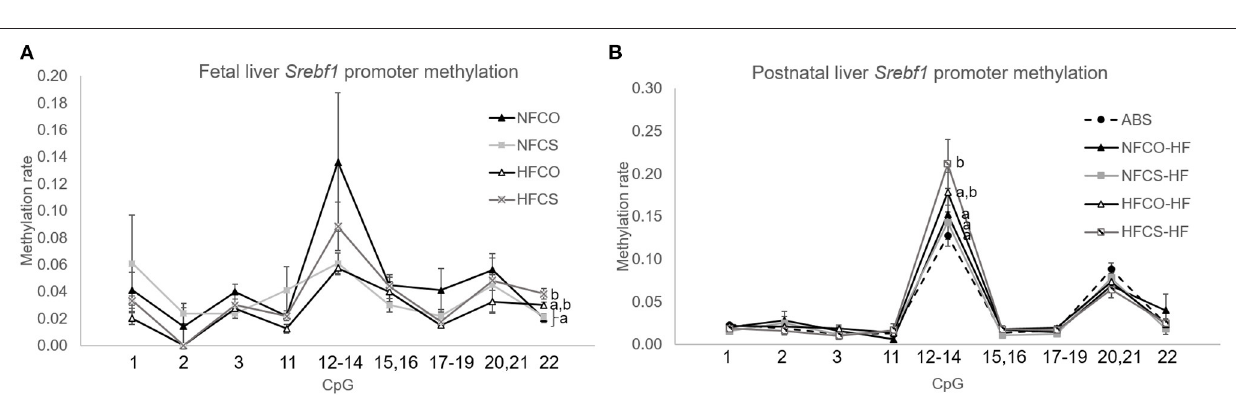
FIGURE 3 | Srebf1 promoter DNA methylation of mouse offspring was modified by maternal HF and CS. Srebf1 methylation at E17.5 (A) and after 6-week post-weaning high-fat feeding (B) . Different letters (e.g., a, b) represent statistically significant difference, p < 0.05. n = 6–8 per sex per group. ABS, absolute control; CO, control without choline supplement; CS, choline supplemented; HF, high-fat; NF, normal-fat.